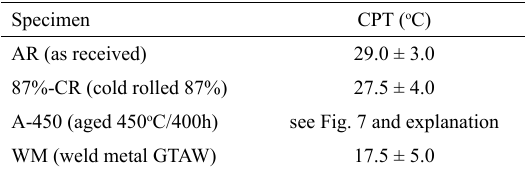
Figure 4. Surfaces observed after cyclic polarization tests: (a) 87%-CR; (b) WM; (c) A-450. Table 5: Average CPT